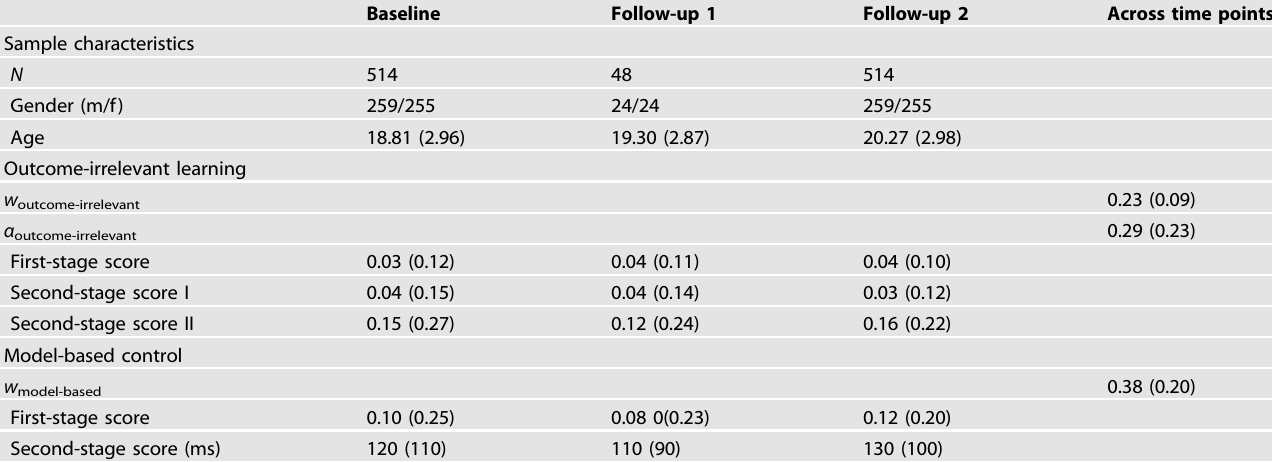
Table 1. Sample characteristics and descriptive data per time